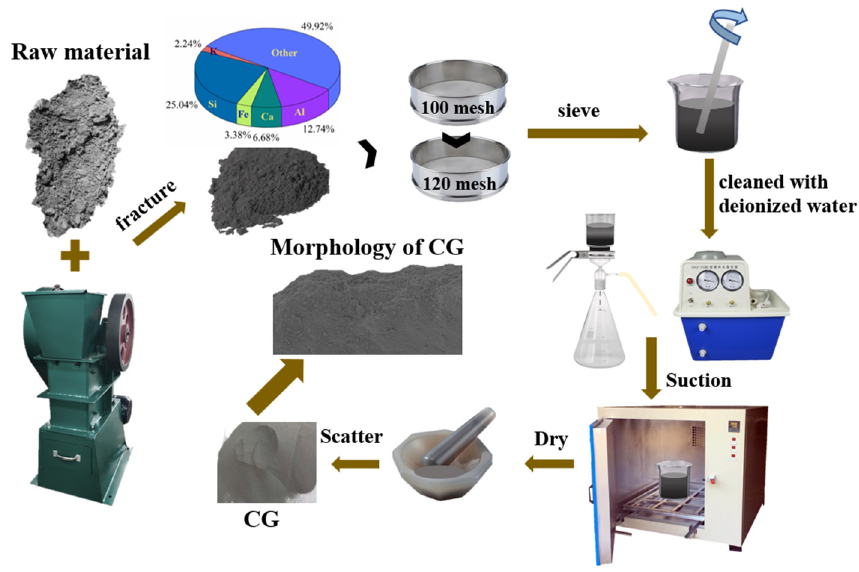
Figure 1. The flow chart for treatment of CG samples derived from the discarded natural coal gangue.